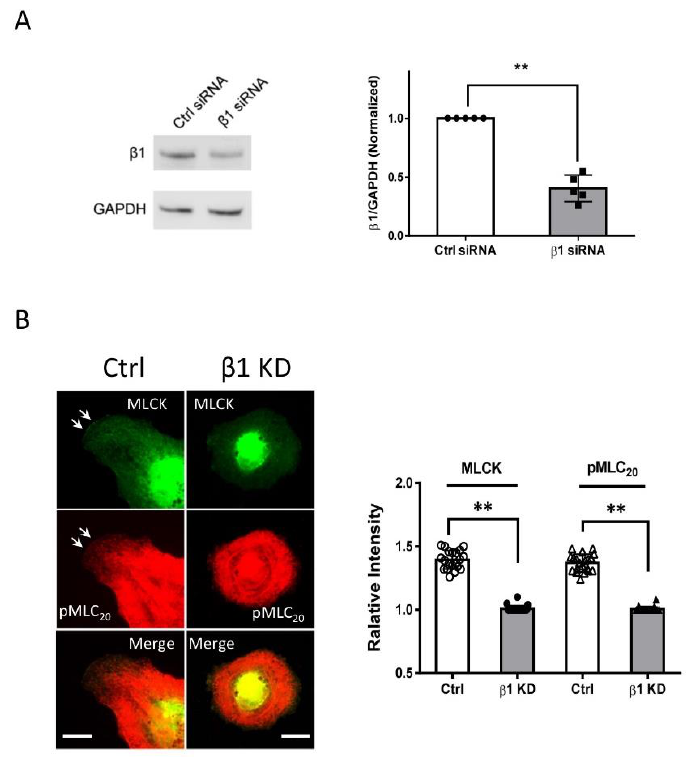
Figure 6. Integrin β 1 controls the positioning of MLCK at the tip of the protrusion. ( A ) Human airway smooth muscle (HASM) cells treated with control (Ctrl) siRNA or β 1 siRNA were evaluated by immunoblot analysis. Data are mean values of experiments from five cultures from three donors. Error bars indicate SD. ( B ) β 1 KD attenuates the positioning of MLCK and pMLC 20 at the cell edge. The arrows point to the leading edge. Scale bar: 10 µ m. Data are mean values of experiments from at least 20 cells for each group. Error bars indicate SD. ** p < 0.01. The t -test was used for statistical analysis.